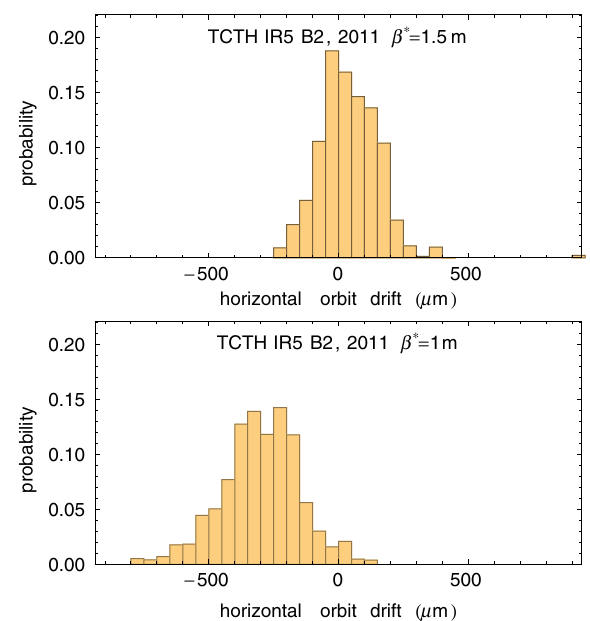
FIG. 4. Measured drifts of the horizontal B2 orbit at a BPM close to the TCTH in IR5 during the first part of the 2011 run with β (cid:1) ¼ 1 . 5 m (top) and during the second part with β (cid:1) ¼ 1 . 0 m (bottom). The orbits were sampled every 10 s.